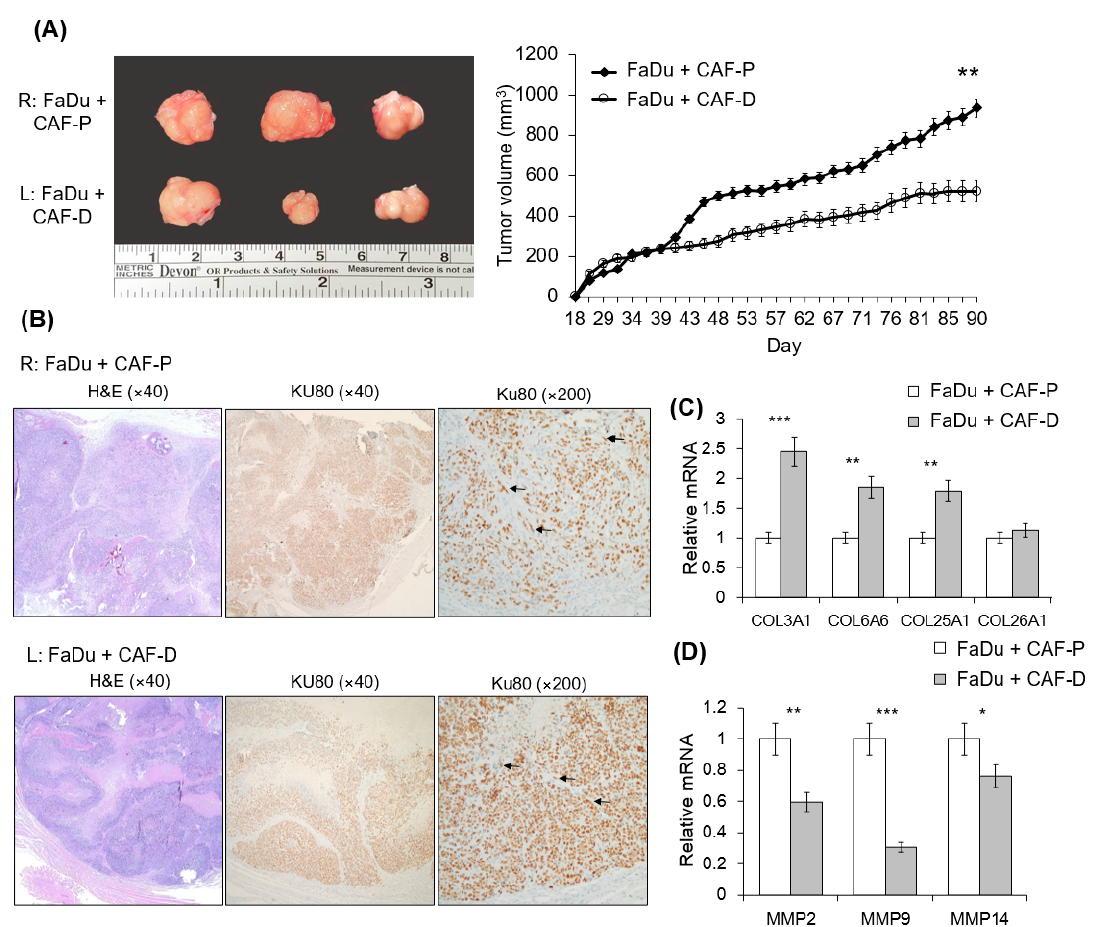
Figure 6. Mouse xenograft tumor formation from FaDu spheroids with CAF-P or CAF-D. FaDu spheroids (<400 μ m in diameter) were prepared in 96-well U-bottom Ultra-Low Attachment plates. Overall, 50 FaDu spheroids (approximately 5 × 10 5 cells) were co-injected with the same number of CAF-P and CAF-D cells into the right and left cheeks of the mouse oral mucosa, respectively. ( A ) Representative images show the appearance of tumors after sacrifice. At 90 days after injection, tumor size was measured using a caliper. ( B ) Immunohistochemical analysis of mice tumor tissues was performed with the Ku80 antibody to evaluate whether they are derived from FaDu and human fibroblasts. Representative Ku80-positive cells are indicated with black arrows. ( C , D ) Collagen and MMP mRNA expression levels in mice tumor tissues were compared. (* p < 0.05, ** p < 0.01, *** p < 0.005).